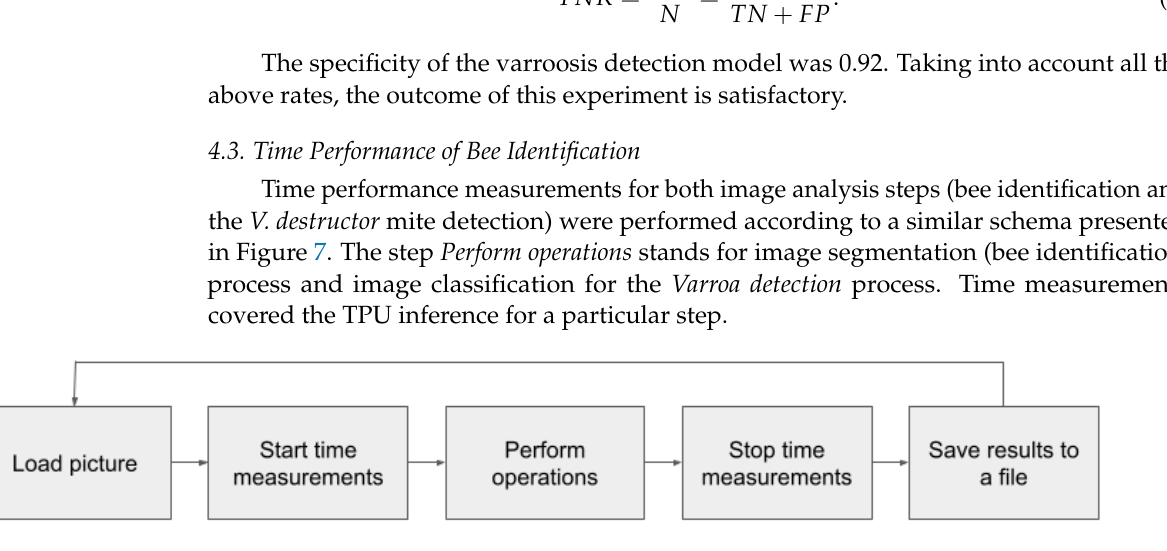
Figure 7. Time performance computing steps for bee identification and Varroa destructor detection.